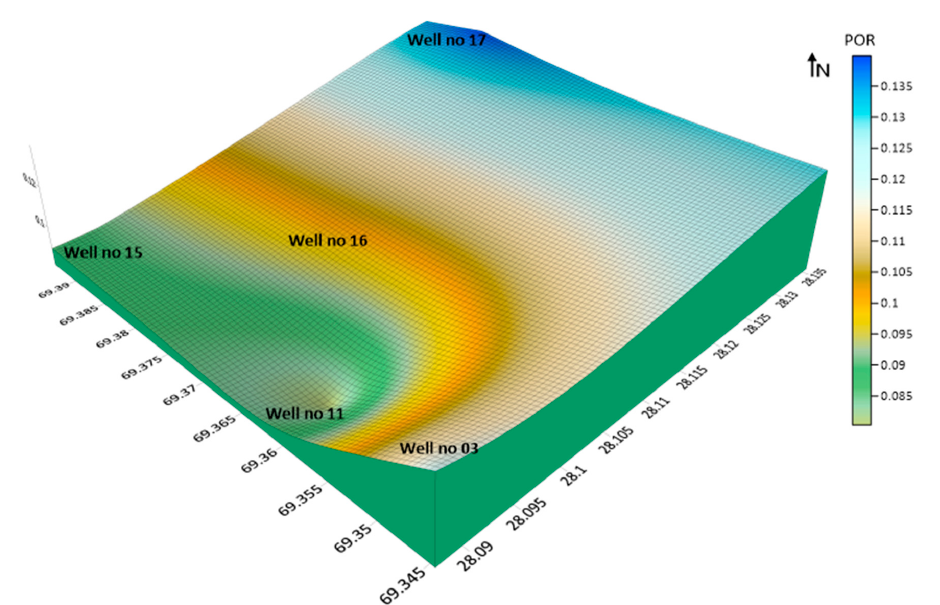
Figure 13. Porosity (POR) variation map computed in (%). Table 3. A brief synopsis of the petrophysical characteristics of the Qadirpur gas field.